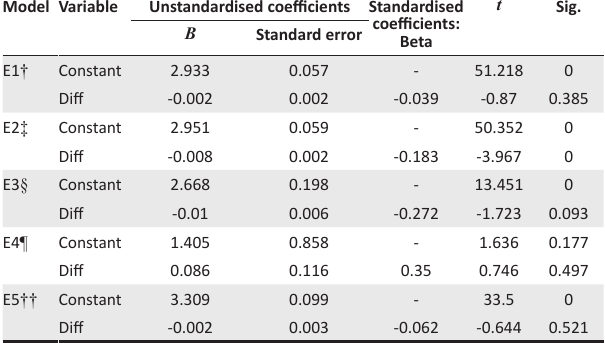
TABLE 6: Conditional regression result of creative talents (educational level). Model Variable